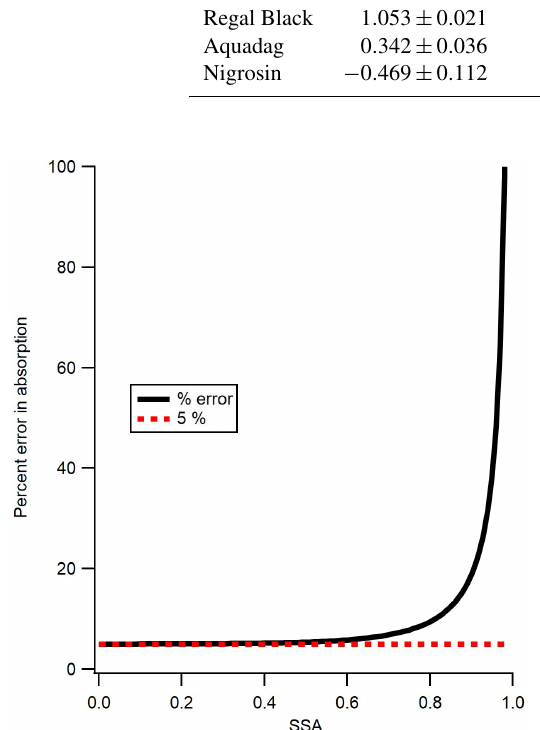
Figure 6. Percent error in absorption versus single-scattering albedo (SSA), following Eq. (4). As SSA approaches zero, absorption error approaches 5%; as SSA approaches 1, the error reaches